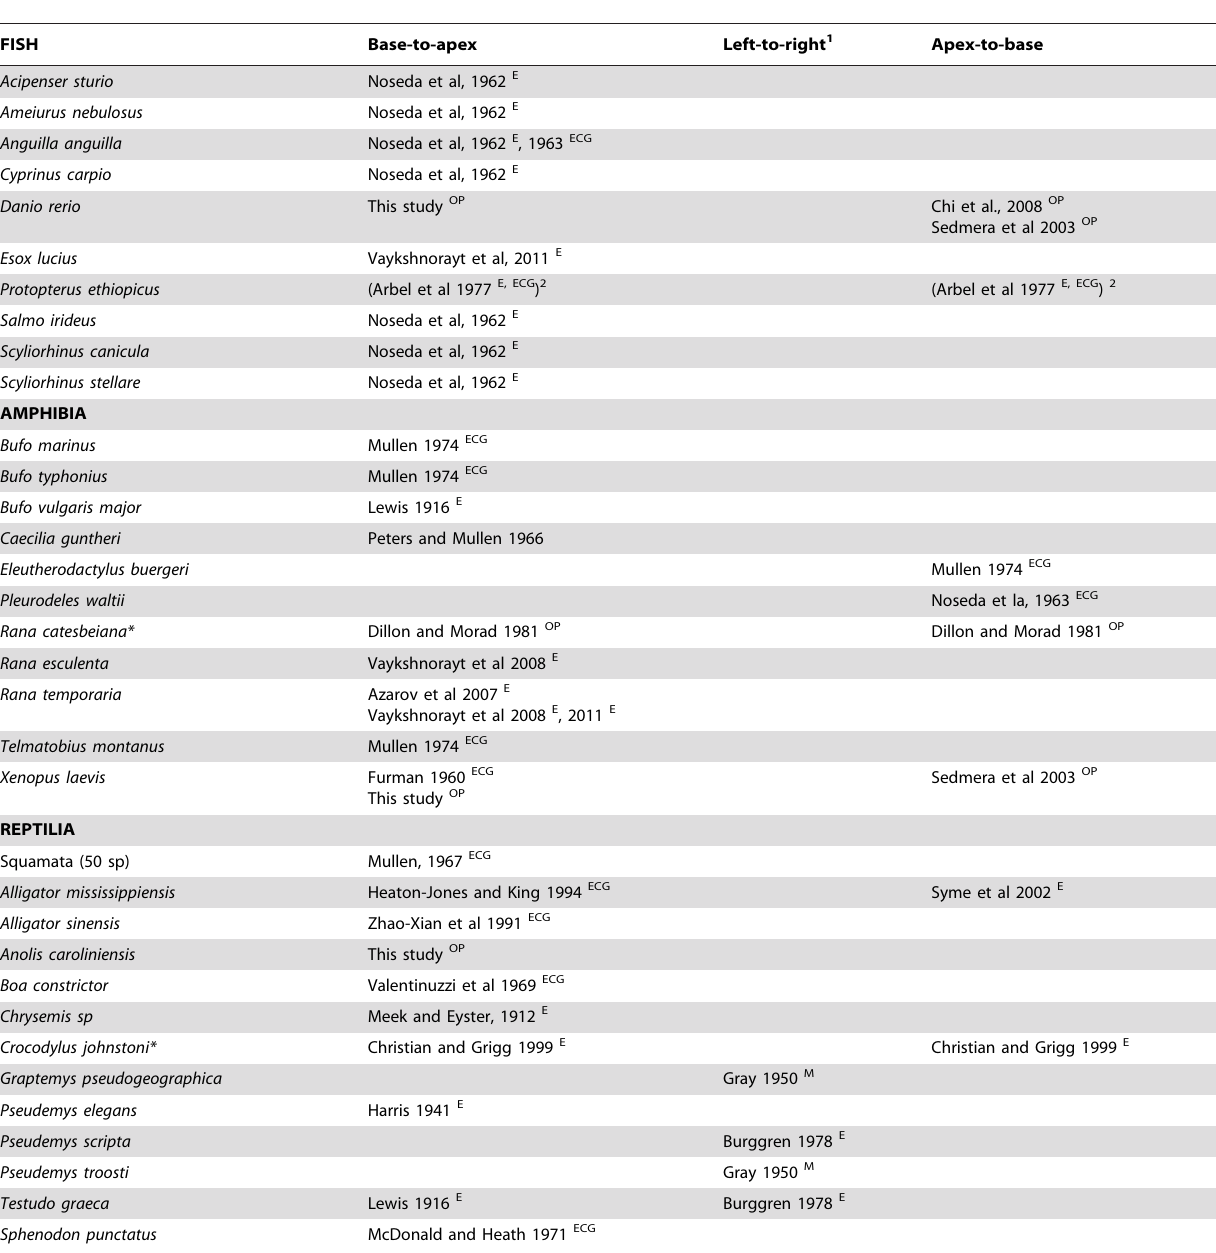
Table 1. Ventricular activation pattern in ectothermic vertebrates investigated by optical mapping( OP ), ECG( ECG ), electrodes( E ) or markers ( M